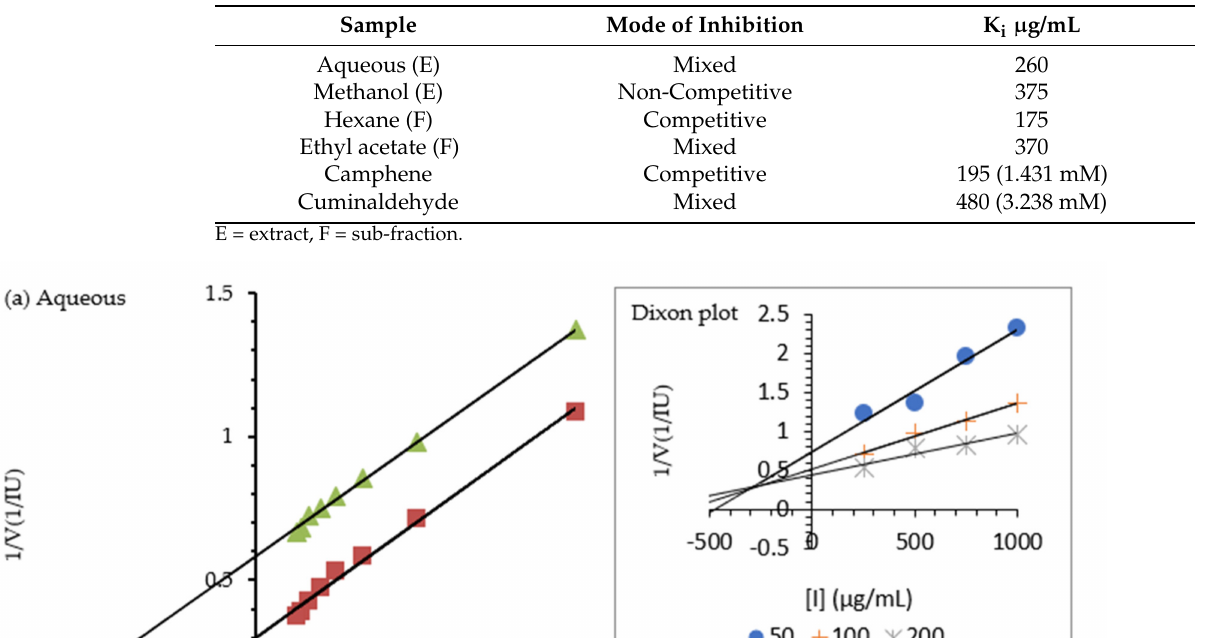
Table 2. Summary of mode of urease inhibition by different samples.